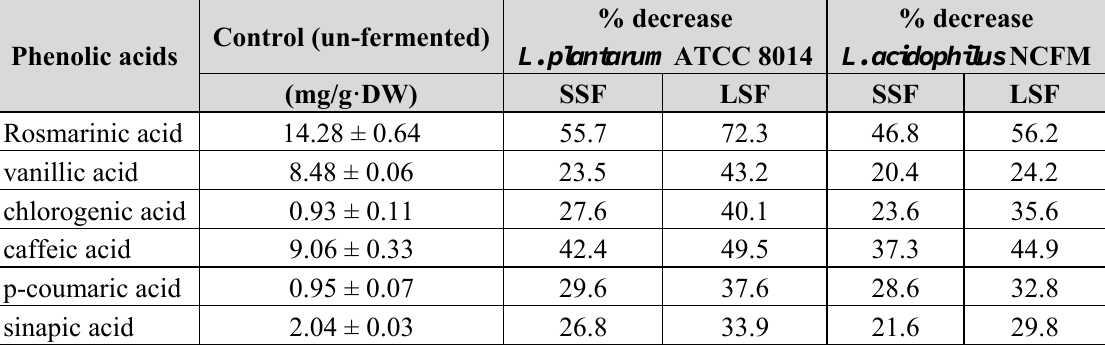
Table 4. Individual response of phenolic acids to the SSF and LSF LAB fermentation of IOSC for 48